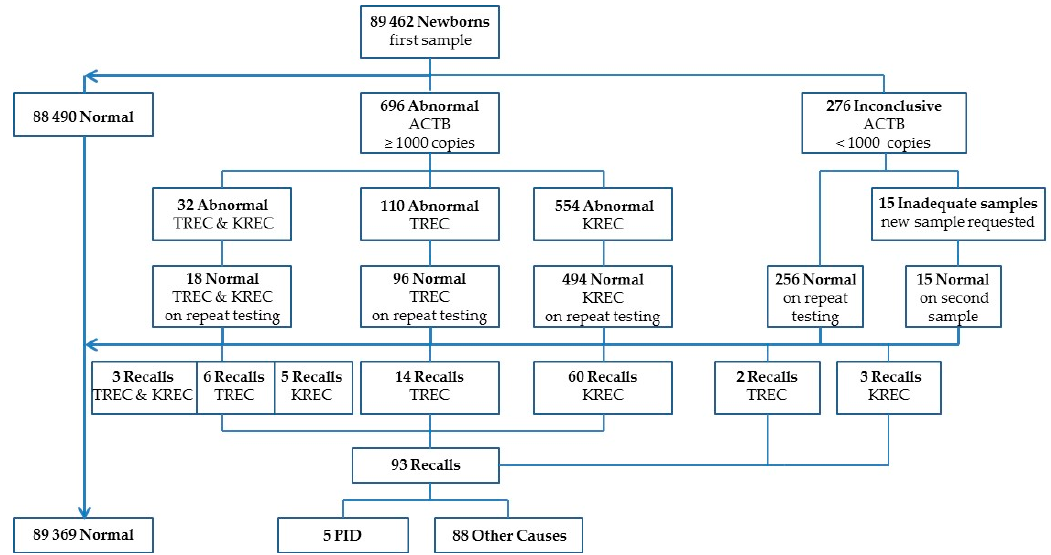
Figure 1. Summary of Newborn screening (NBS) results between 15 November 2013 and 14 November 2016.